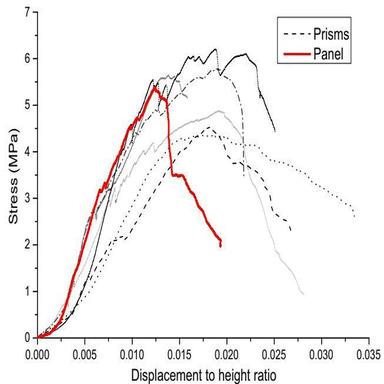
Respond curves of stress versus displacement to height ratio of masonry prisms and panel under uniaxial compression.